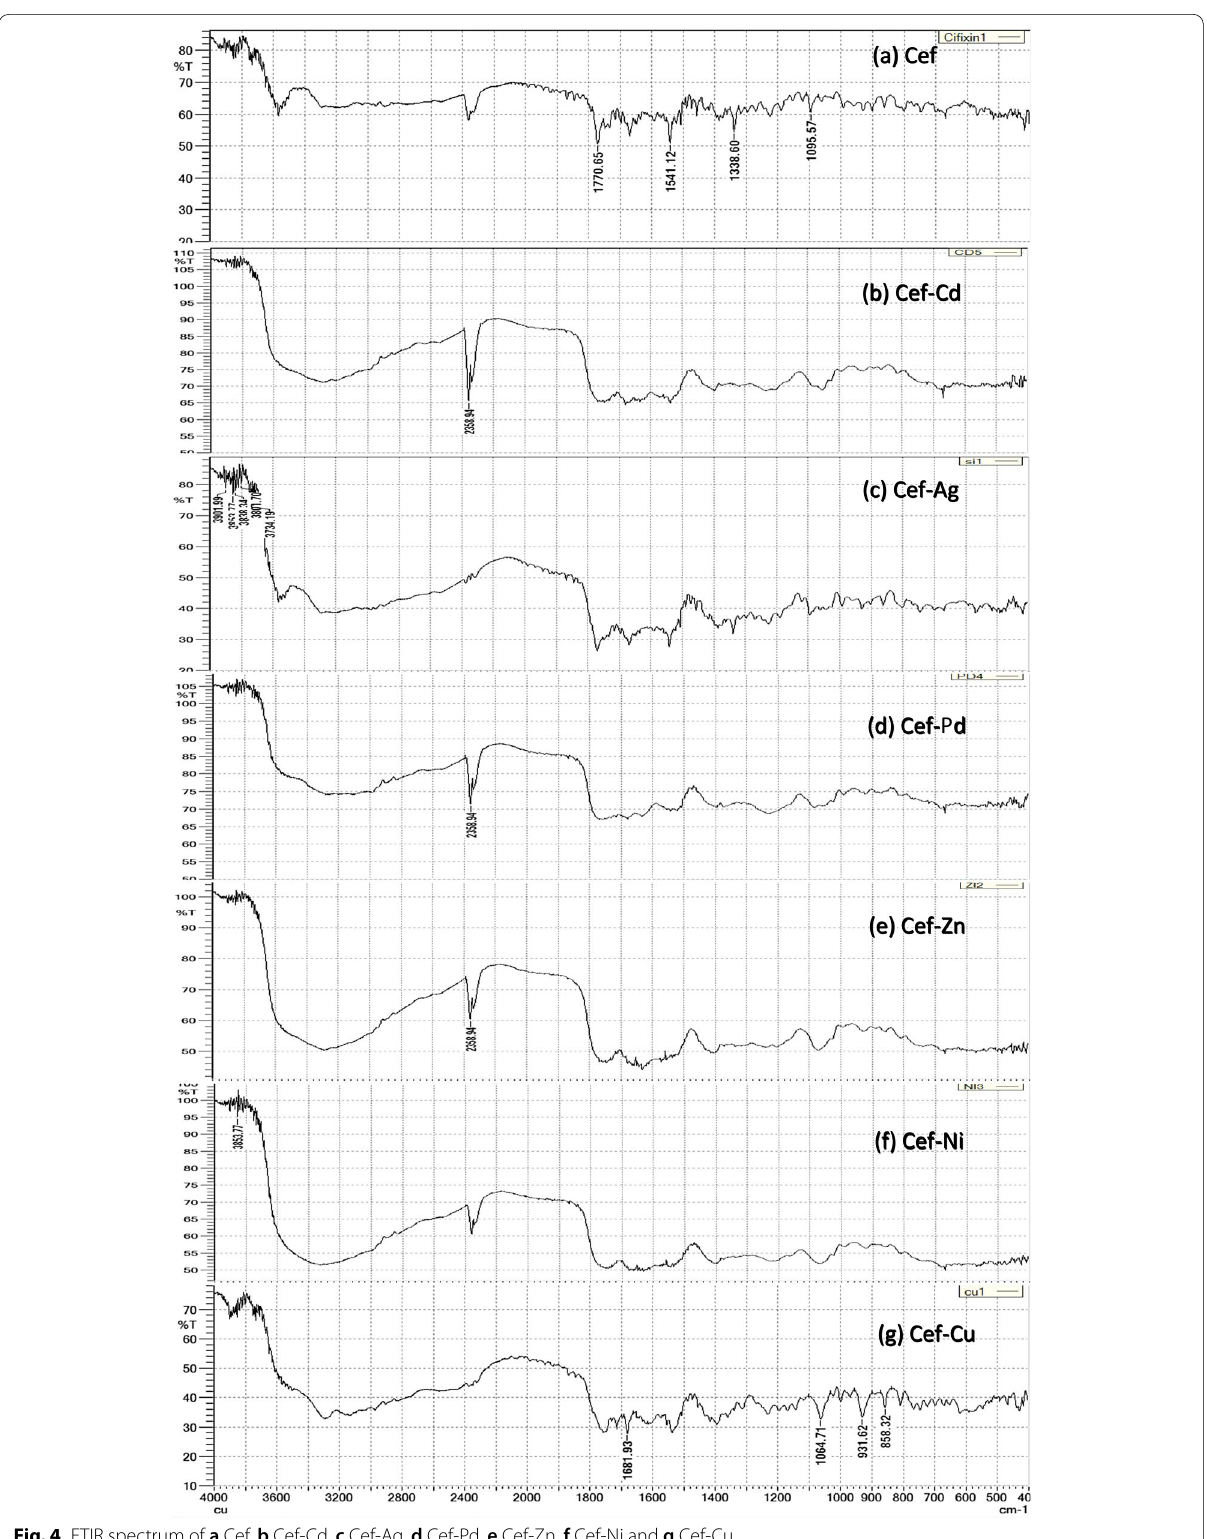
Fig. 4 FTIR spectrum of a Cef, b Cef-Cd, c Cef-Ag, d Cef-Pd, e Cef-Zn, f Cef-Ni and g